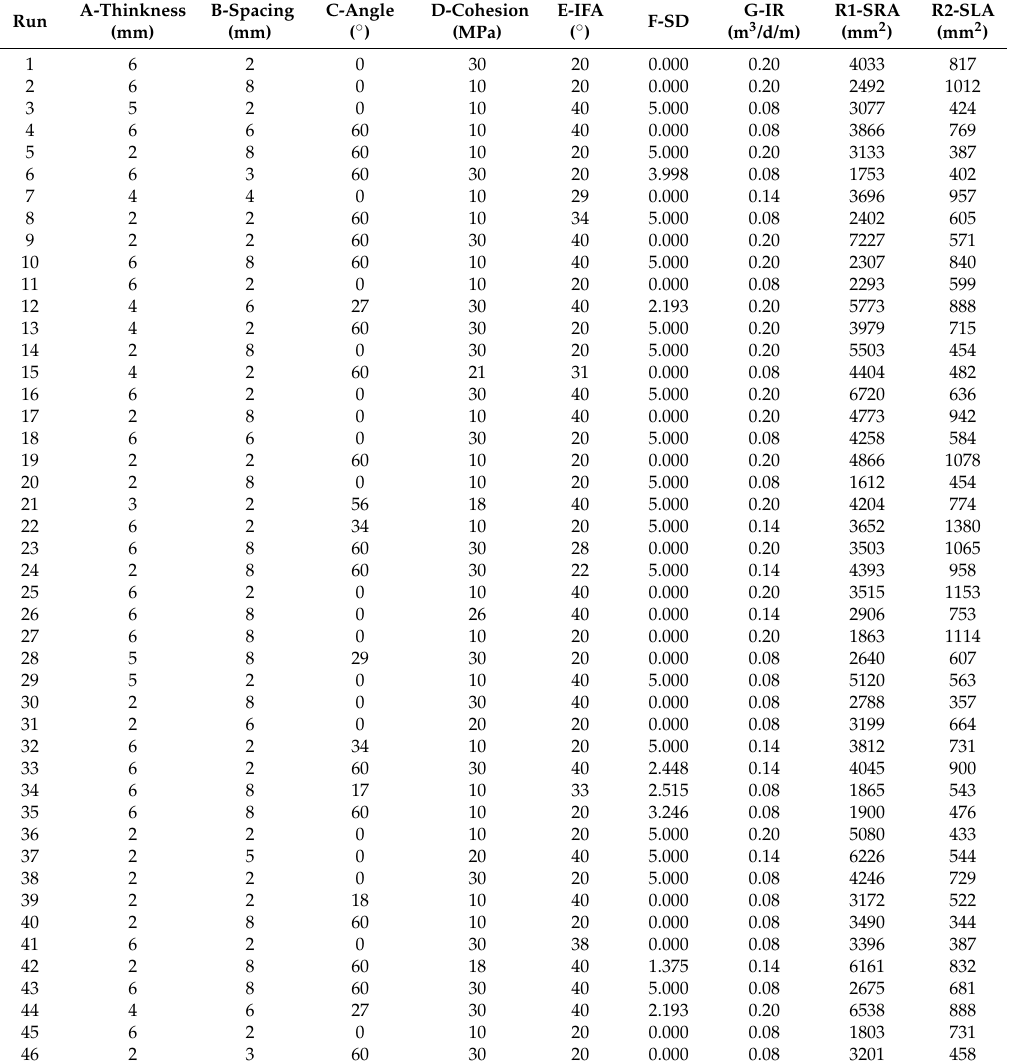
Table 3. D-Optimal design table for the hydraulic fracturing simulations. SRA: stimulated reservoir area; SLA: silty laminae